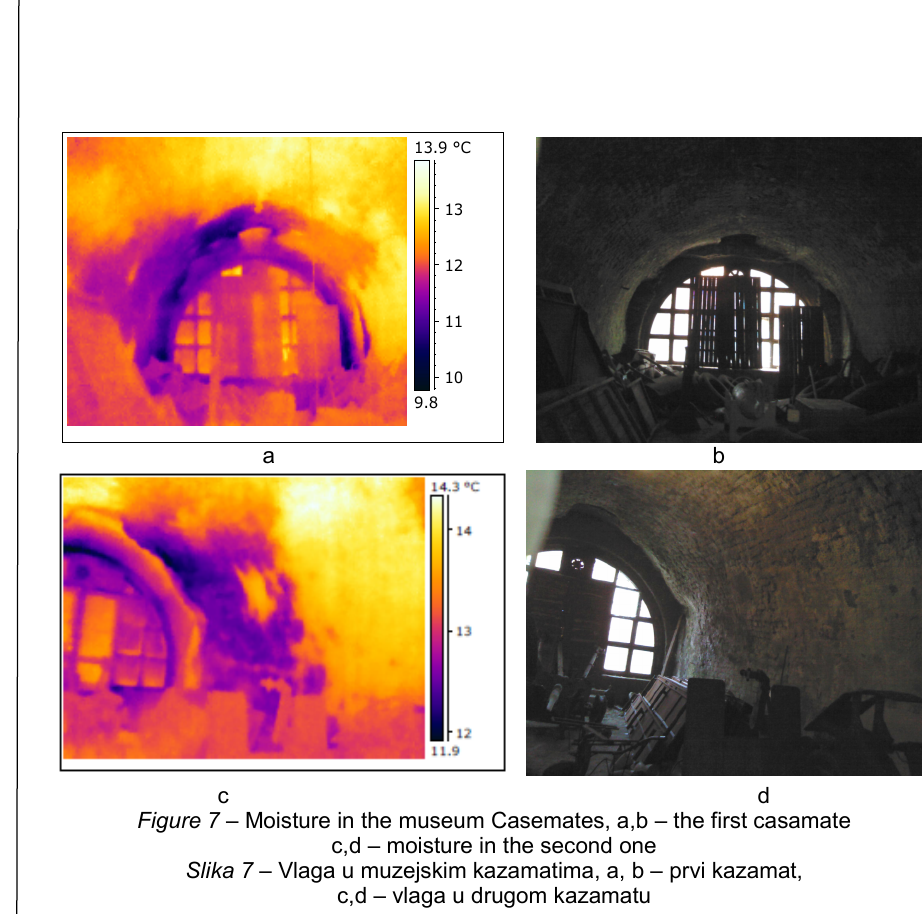
Figure 7 – Moisture in the museum Casemates, a,b – the first casamate c,d – moisture in the second